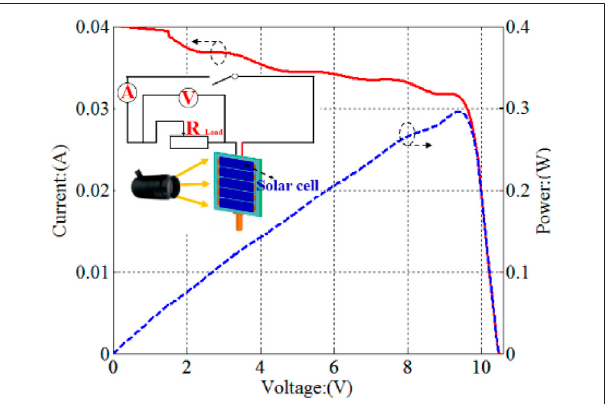
FIGURE 11 | The setup and measured results of the optical